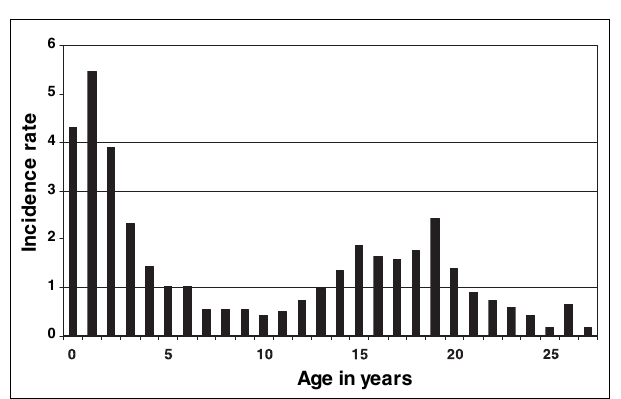
Figure 2) Incidence rate (per 100,000 per year) of invasive meningo- coccal disease in Quebec, according to age, from 1990 to 1992. Data from the Quebec Ministry of Health, written